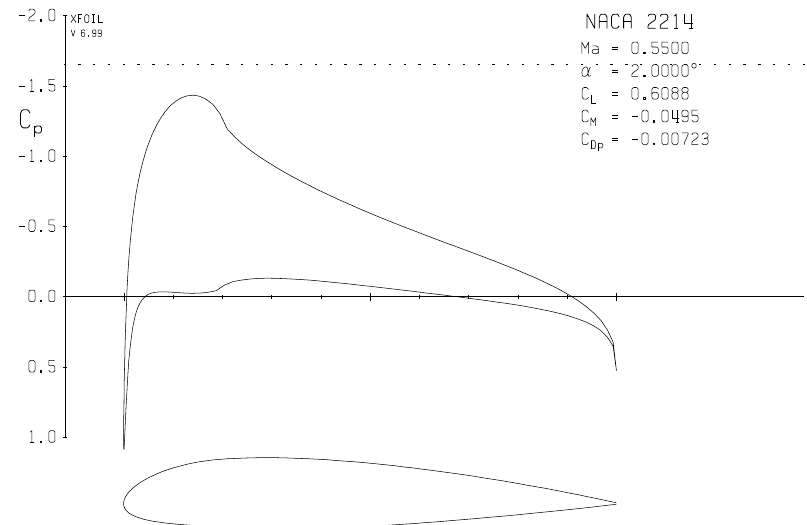
Figure 20. The airfoil surface pressure coefficient distribution for NACA 2214 airfoil ( M ∞ = 0.55, α = 2 ◦ ) using XFOIL. Table 1. Drag and lift coefficients using different grid sizes. Codes FOILcom and XFOIL are used. Code and Grid